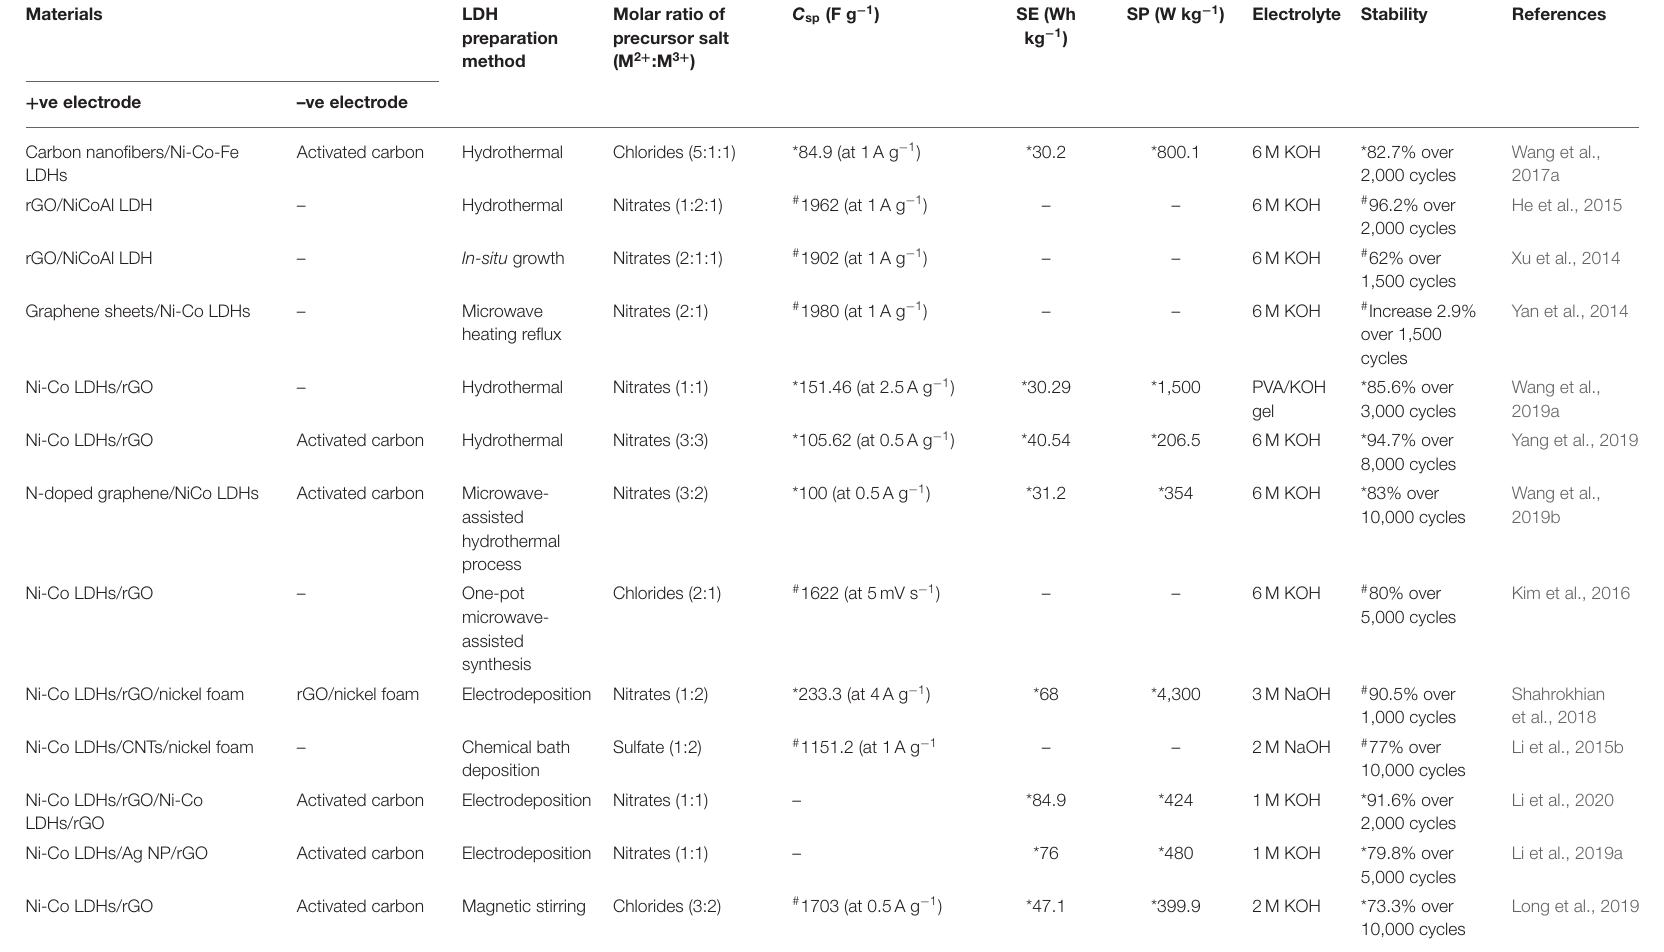
TABLE 4 | Summary of nanocomposites containing carbon-based materials with Ni 2 + / Co 2 +